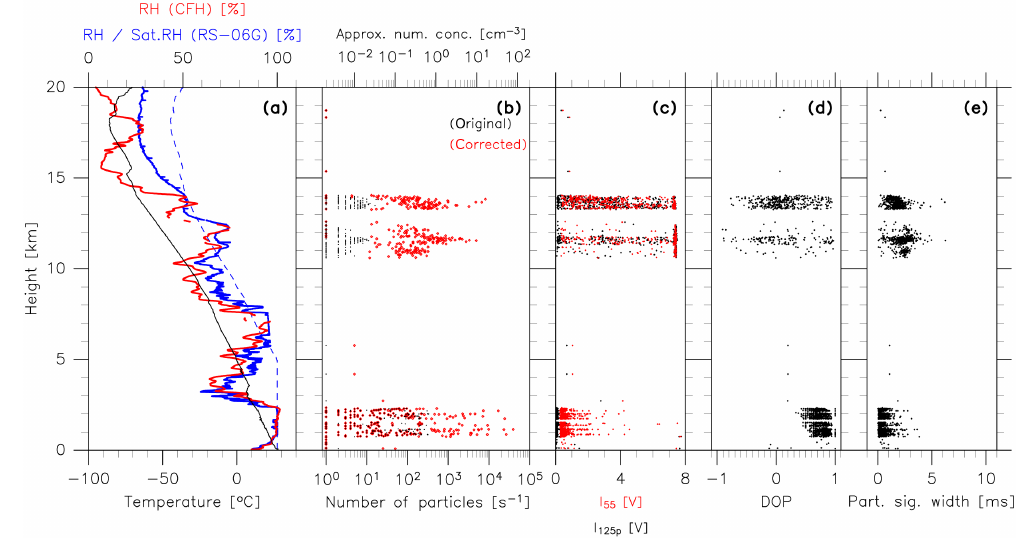
Figure 9. As for Fig. 8, but for the profiles taken at Biak launched at 18:00LT on 27 February